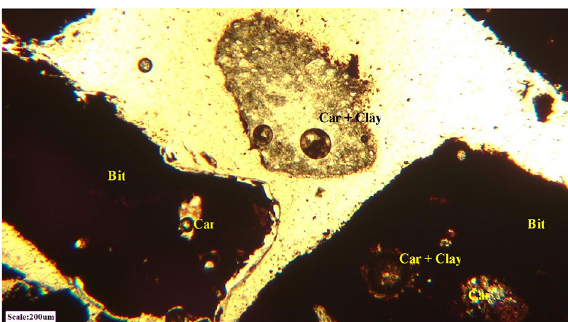
Figure 1. Microphotograph of interlocking between bitumen (Bit) and carbonate (Car) and clay minerals—in plane polarized light (PPL).